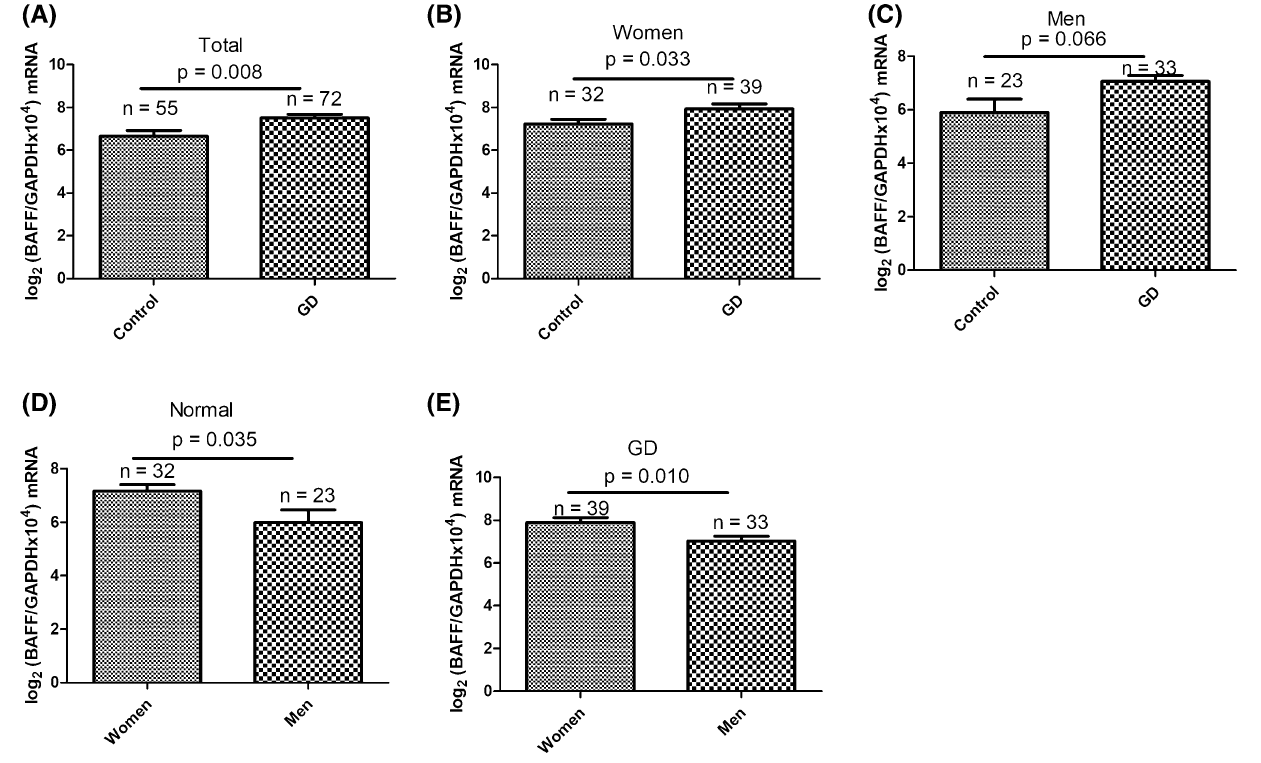
Figure 2. Comparison of B-cell-activating factor (BAFF) mRNA levels from peripheral blood mononuclear cells (PBMCs) between Graves’ disease (GD) patients and healthy controls and in ( A ) all, ( B ) female, and ( C ) male subjects, and differences in BAFF mRNA levels between women and men in normal subjects ( D ) and GD patients ( E